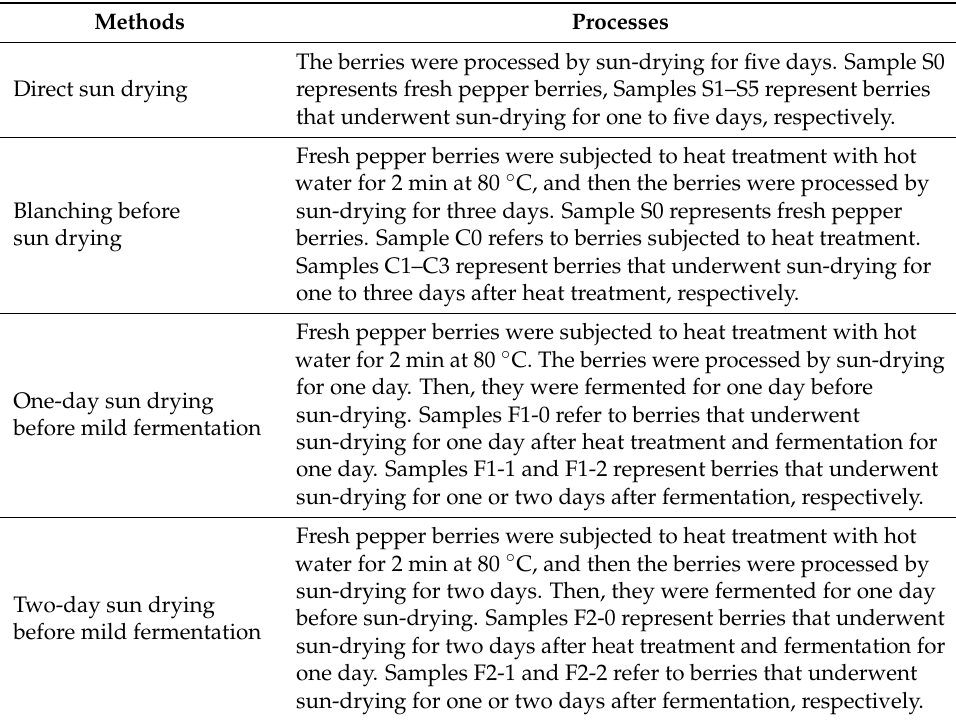
Table 1. The four treatment methods of black